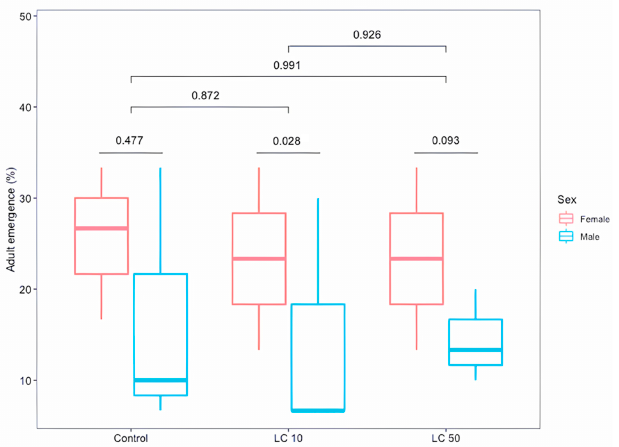
Table 2. Pathogenicity of Metarhizium robertsii V3 ‐ 160 to 7 d ‐ old, parasitizedlarvae of Anastrepha ludens parasitized by Diachasmimorpha longicaudata , via topical application.